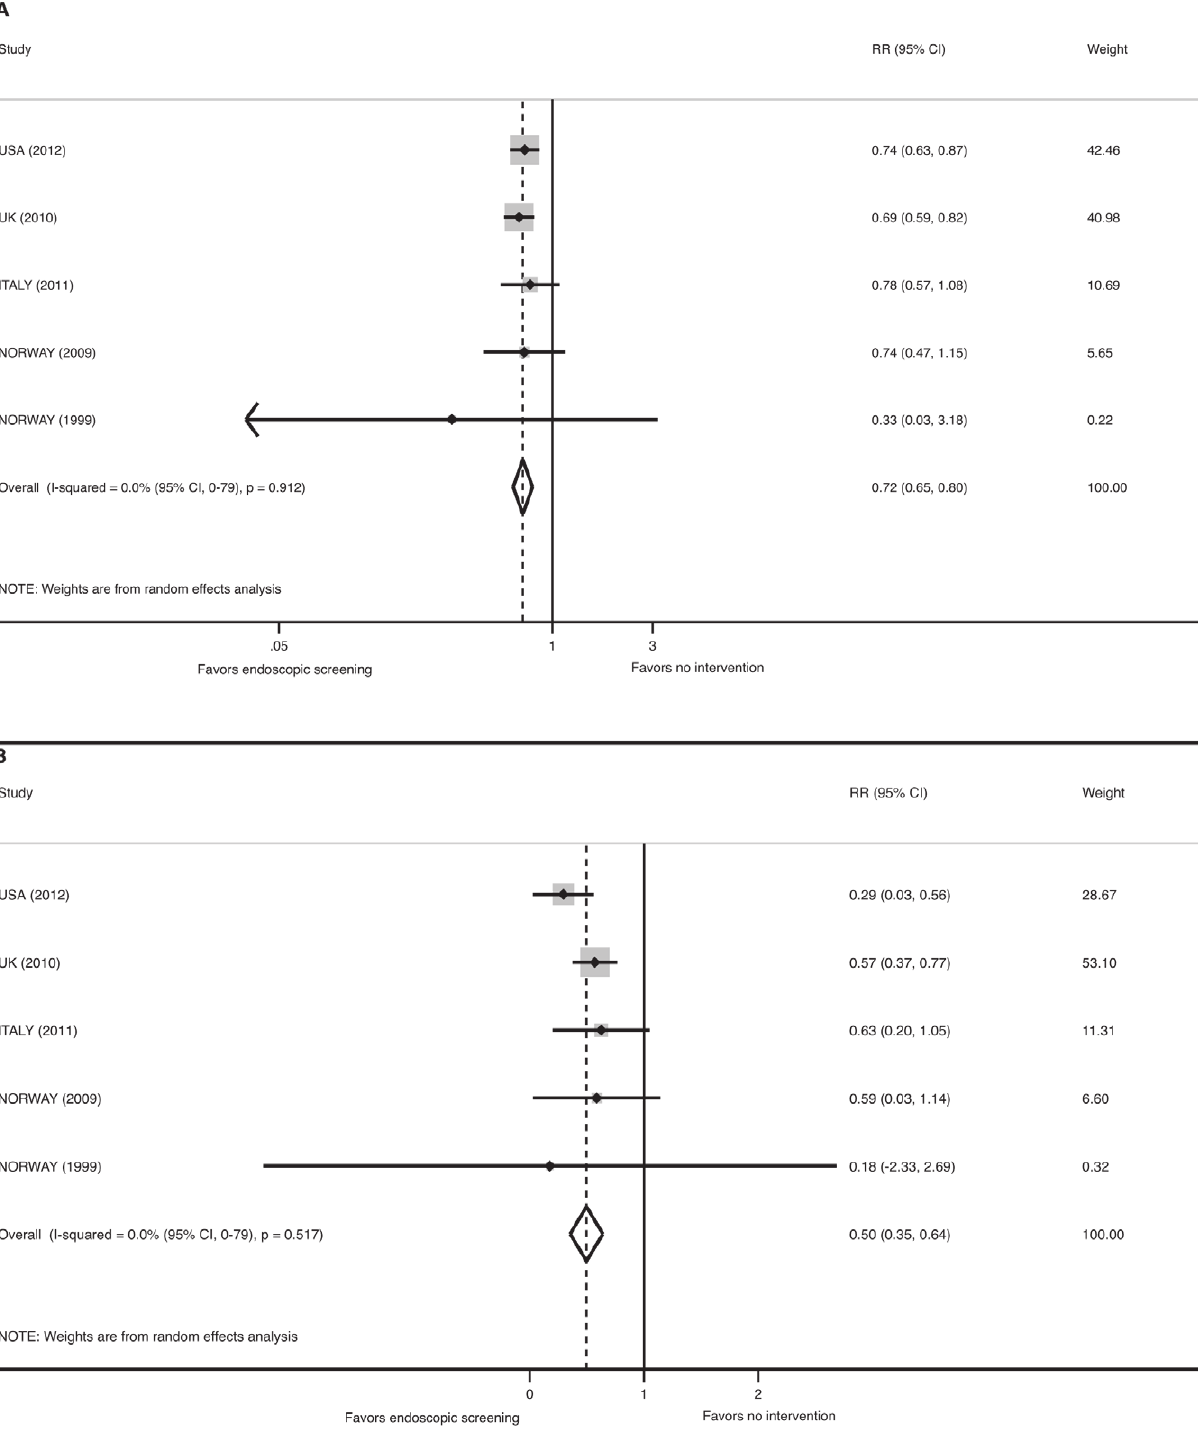
There was evidence of significant heterogeneity among the five RCTs for the endpoint proximal (non left-sided) CRC ( p , 0.001, I- squared = 86.0% [95% CI 69–94]). The random effects meta- analysis revealed a pooled relative risk for the incidence of right-